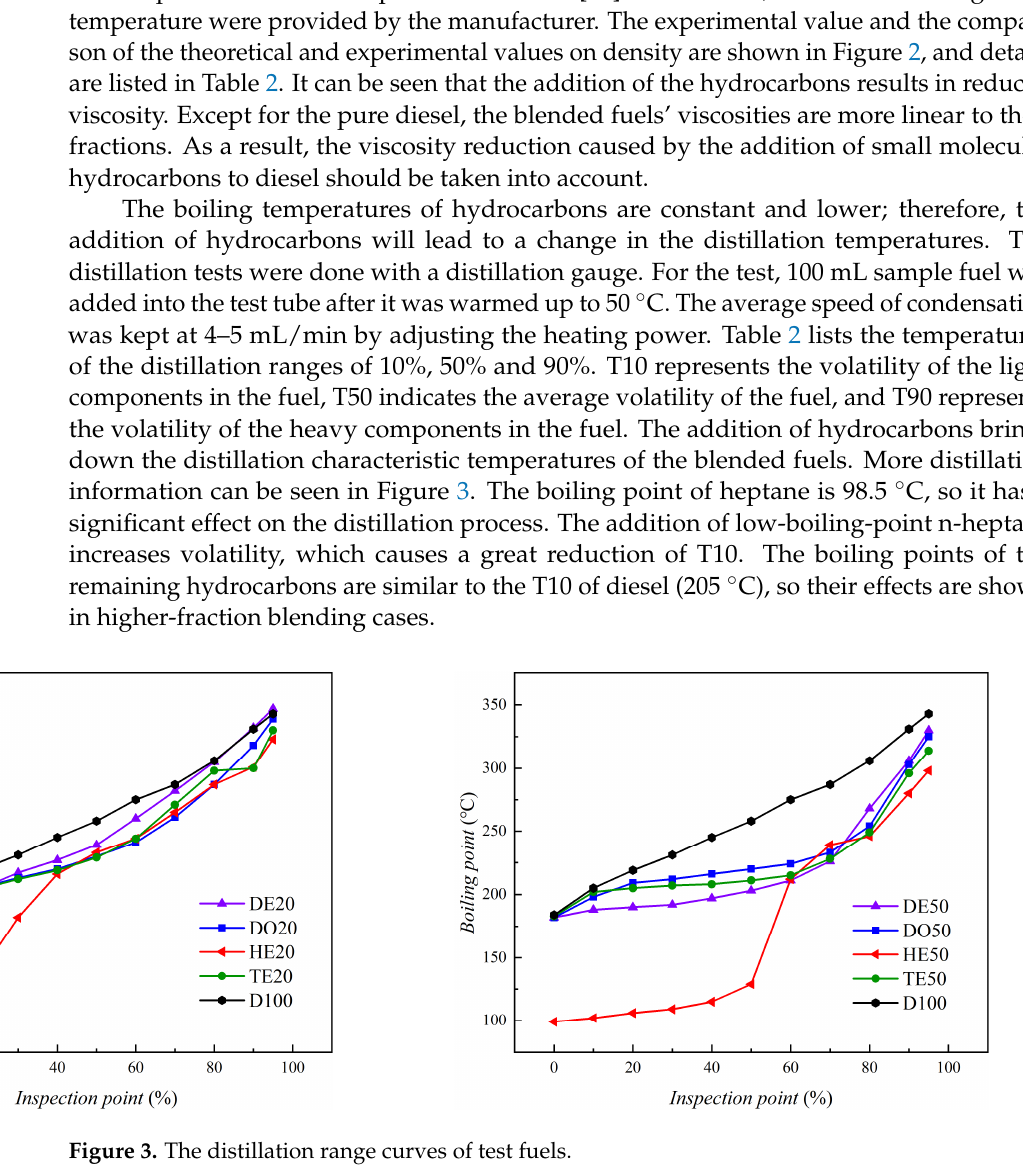
Figure 3. The distillation range curves of test fuels.